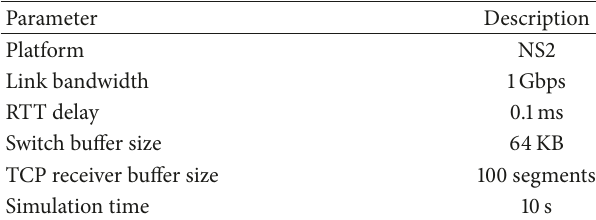
Table 3: Parameter